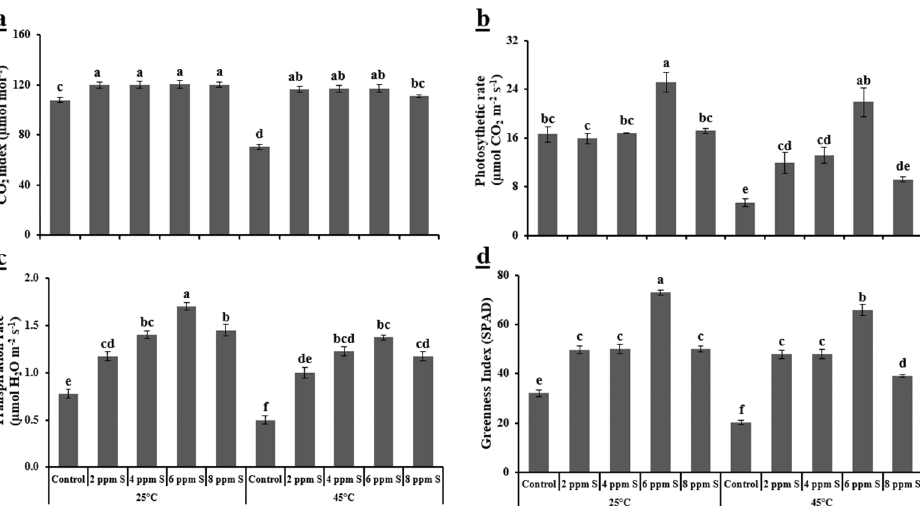
Figure 6. Physiological variables [i.e., CO 2 index ( a ), photosynthetic rate ( b ), transpiration rate ( c ), greenness index ( d )] of tomato plants (cv. Ahmar) as affected by temperature and exogenous application of S. Same letters indicate non-significant differences among treatments according to Tukey’s honestly significant difference test ( p ≤ 0.05). Vertical bars indicate averages ± standard errors ( n = 4, 5 plants per replicate).